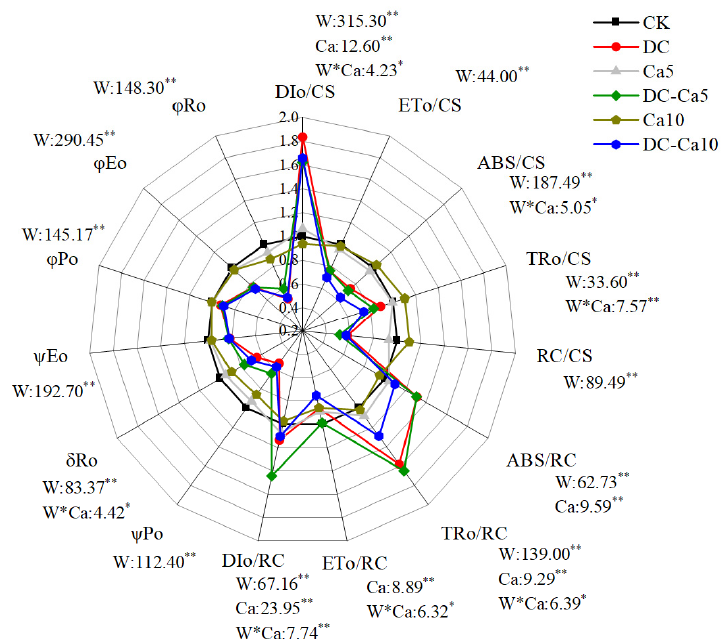
Figure 7. A ‘spider plot’ of well water (WW), water stress (WS), and different calcium (Ca) concen- trations on specific energy fluxes (ABS/RC, TRo/RC, ETo/RC, and DIo/RC), phenomenological energy fluxes (ETo/CS, ABS/CS, TRo/CS, and DIo/CS) and the quantum yields and efficiency ( ψ Eo, ψ Po, δ Ro, φ Po, φ Eo, and φ Ro). All data are normalized to the control and all variables are normal- ized to provide a value of 1. The single * in the upper right corner indicated a significant effect at 0.05 level, and the double * indicated a significant effect at 0.001 level. F is not provided when Ca, W, and their interactions are not significant. ψ Eo = ETo/TRo= (1 − V J ), ψ Po = REo/TRo= (1 − V I ), δ Ro = REo/ETo = (1 − V I )/(1 − V J ), φ Po = TRo/ABS = Fv/Fm, φ Eo = ETo/ABS = [1 − (Fo/Fm)] ψ Eo, φ Ro = REo/ABS = (1 − VJ) φ Po. ABS/RC = Mo (1/V J ) (1/ φ Po), TRo/RC = Mo (1/V J ), ETo/RC = Mo (1/V J ) ψ Eo, DIo/RC = (ABS/RC) − (TRo/RC). ABS/CS = Fm, TRo/CS = φ Po (ABS/CS), DIo/CS = (ABS/CS) − (TRo/CS), ETo/CS = φ Eo (ABS/CS).